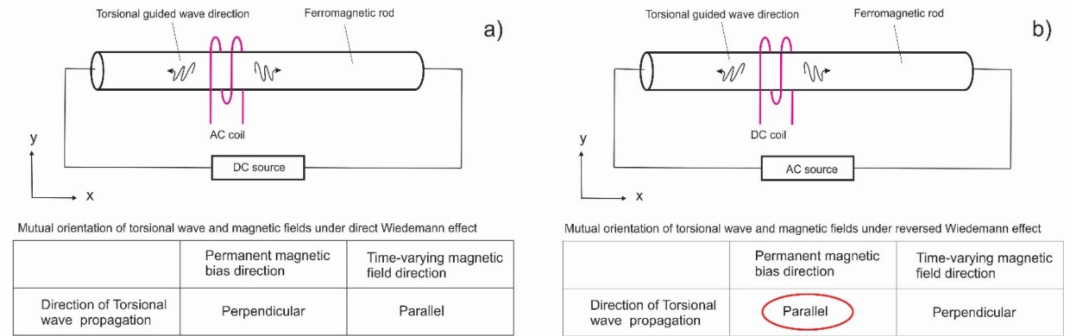
Figure 1. Two alternative implementations of Wiedemann effect: ( a ) direct Wiedemann effect when the circumferential field is permanent, and ( b ) a reversed Wiedemann effect when the circumferential field is